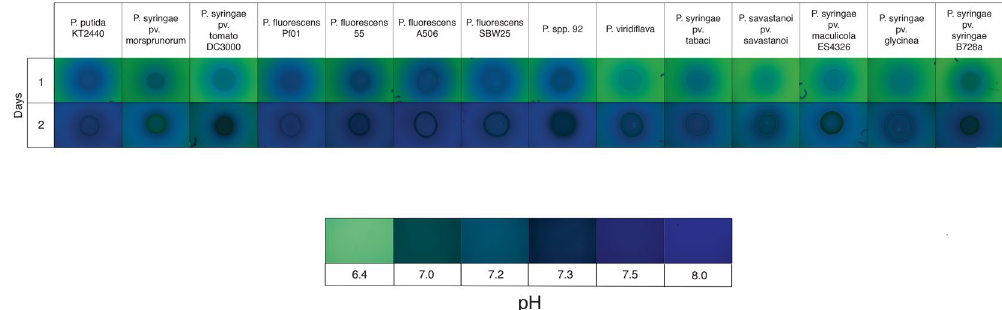
Figure 1. Pictures of Pseudomonas species grown on NB agar supplemented with calcium and 0.1% (w/v) BB over the course of two days. Pictures are of the same colony on day one and day two. The relative pH of the media can be determined by the change in the color of BB. Pictures of the color change in NB agar supplemented with calcium and 0.1% (w/v) BB from a pH of 6.4 to 8.0 is shown below the pictures of the bacterial colonies. This assay was repeated three separate times and the pictures are representative of those